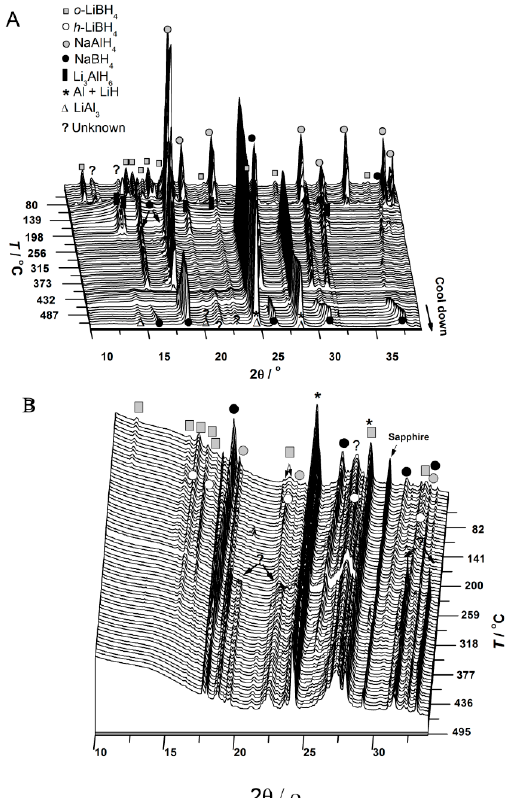
Figure 1. In situ SR-PXD during dehydrogenation of ( A ) bulk 2LiBH 4 -NaAlH 4 heated from room temperature (RT) to 487 ° C, with subsequent natural cooling to RT in p (H 2 ) = 1 bar and temperature (RT) to 487 ˝ C, with subsequent natural cooling to RT in p (H 2 ) = 1 bar and ( B ) nanoconfined ( B ) nanoconfined 2LiBH 4 -NaAlH 4 in carbon aerogel (CA) heated from RT to 495 °C ( Δ T / Δ t = 5 °C/min, 2LiBH 4 -NaAlH 4 in carbon aerogel (CA) heated from RT to 495 ˝ C ( ∆ T / ∆ t = 5 ˝ C/min, λ = 0.991779 λ = 0.991779 Å).